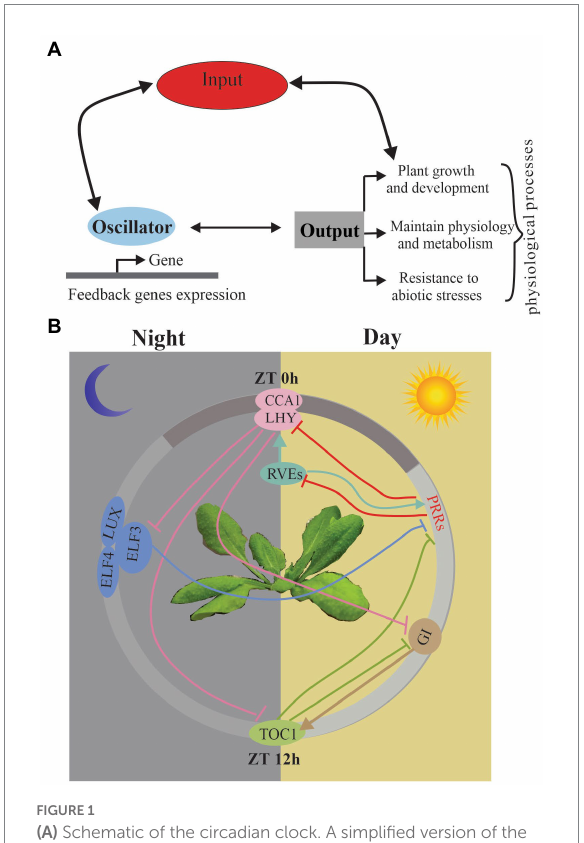
FIGURE 1 (A) Schematic of the circadian clock. A simplified version of the main functional modules of the circadian system; arrows indicate the relationship between modules. (B) The current model of A . thaliana circadian oscillator network with detailed model for transcriptional regulation among the clock components. It shows the relative time of action of each component from left to right in a circadian cycle. The white area indicates subjective day; gray area indicates subjective night. Arrows indicate induction, while perpendicular lines indicate transcriptional